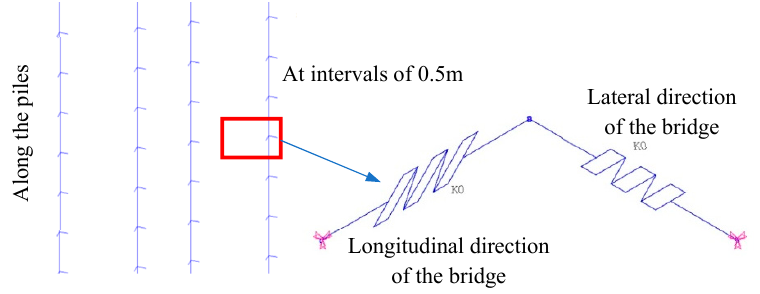
Figure 12. Simulation of the pile-soil interaction.